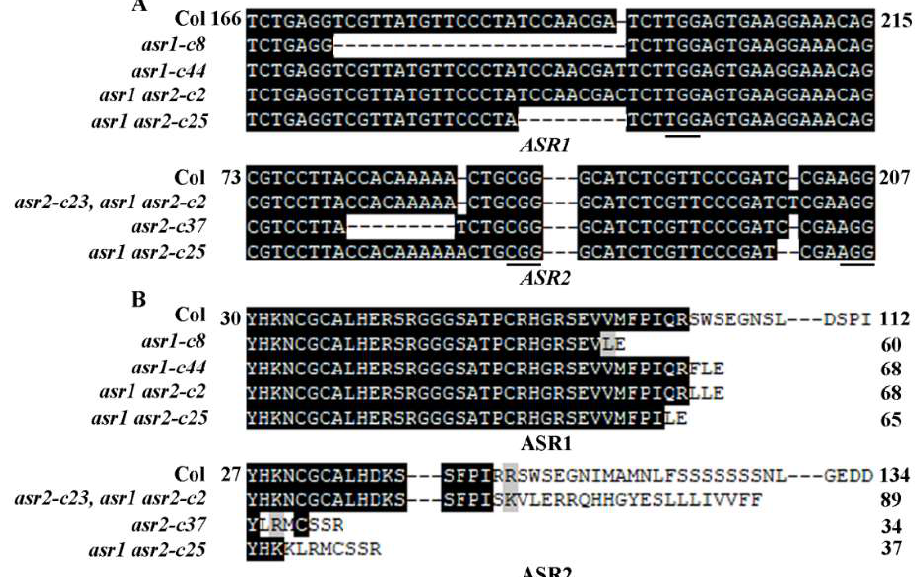
Figure 3. Generation of gene-edited mutants for ASR1 and ASR2 . ( A ) Editing status of ASR1 and ASR2 in the asr1 and asr2 single and the asr1 asr2 double mutants. DNA was extracted from leaves of normal flowering T2 plants and used for RT-PCR amplification of ASR1 and ASR2 . The PCR products were sequenced, and the sequences obtained were aligned with the ASR1 and ASR2 sequences from the Col wild-type plants. Underlines indicate the PAM sites, and numbers indicate the position of the nucleotide relative to the first nucleotide of the wild-type ASR1 and ASR2 ORFs. ( B ) Amino acid alignment of ASR1 and ASR2 in the Col wild type, the asr1 and asr2 single and the asr1 asr2 double mutants. The ORFs of ASR1 and ASR2 in the asr1 and asr2 single and the asr1 asr2 double mutants were identified by using ORF finder (https://www.ncbi.nlm.nih.gov/orffinder/, accessed on 31 January 2022), and corresponding amino acids were then used for sequence alignment. Numbers indicate the position of the amino acid relative to the first amino acid of the wild-type ASR1 and ASR2